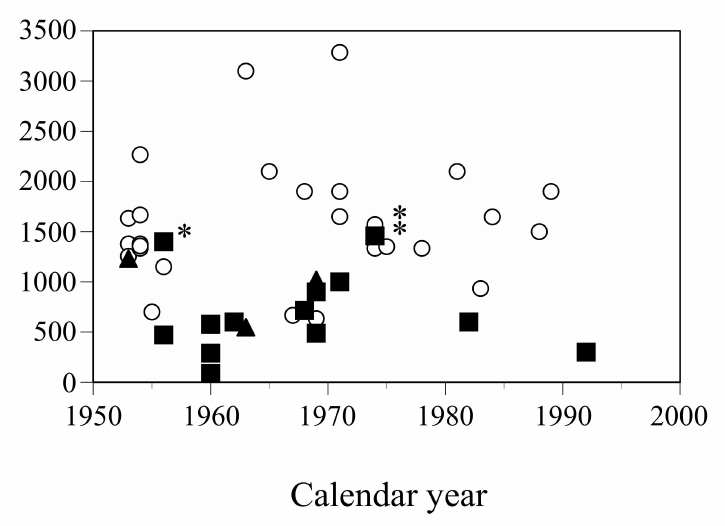
, healthy appearing (cid:35)